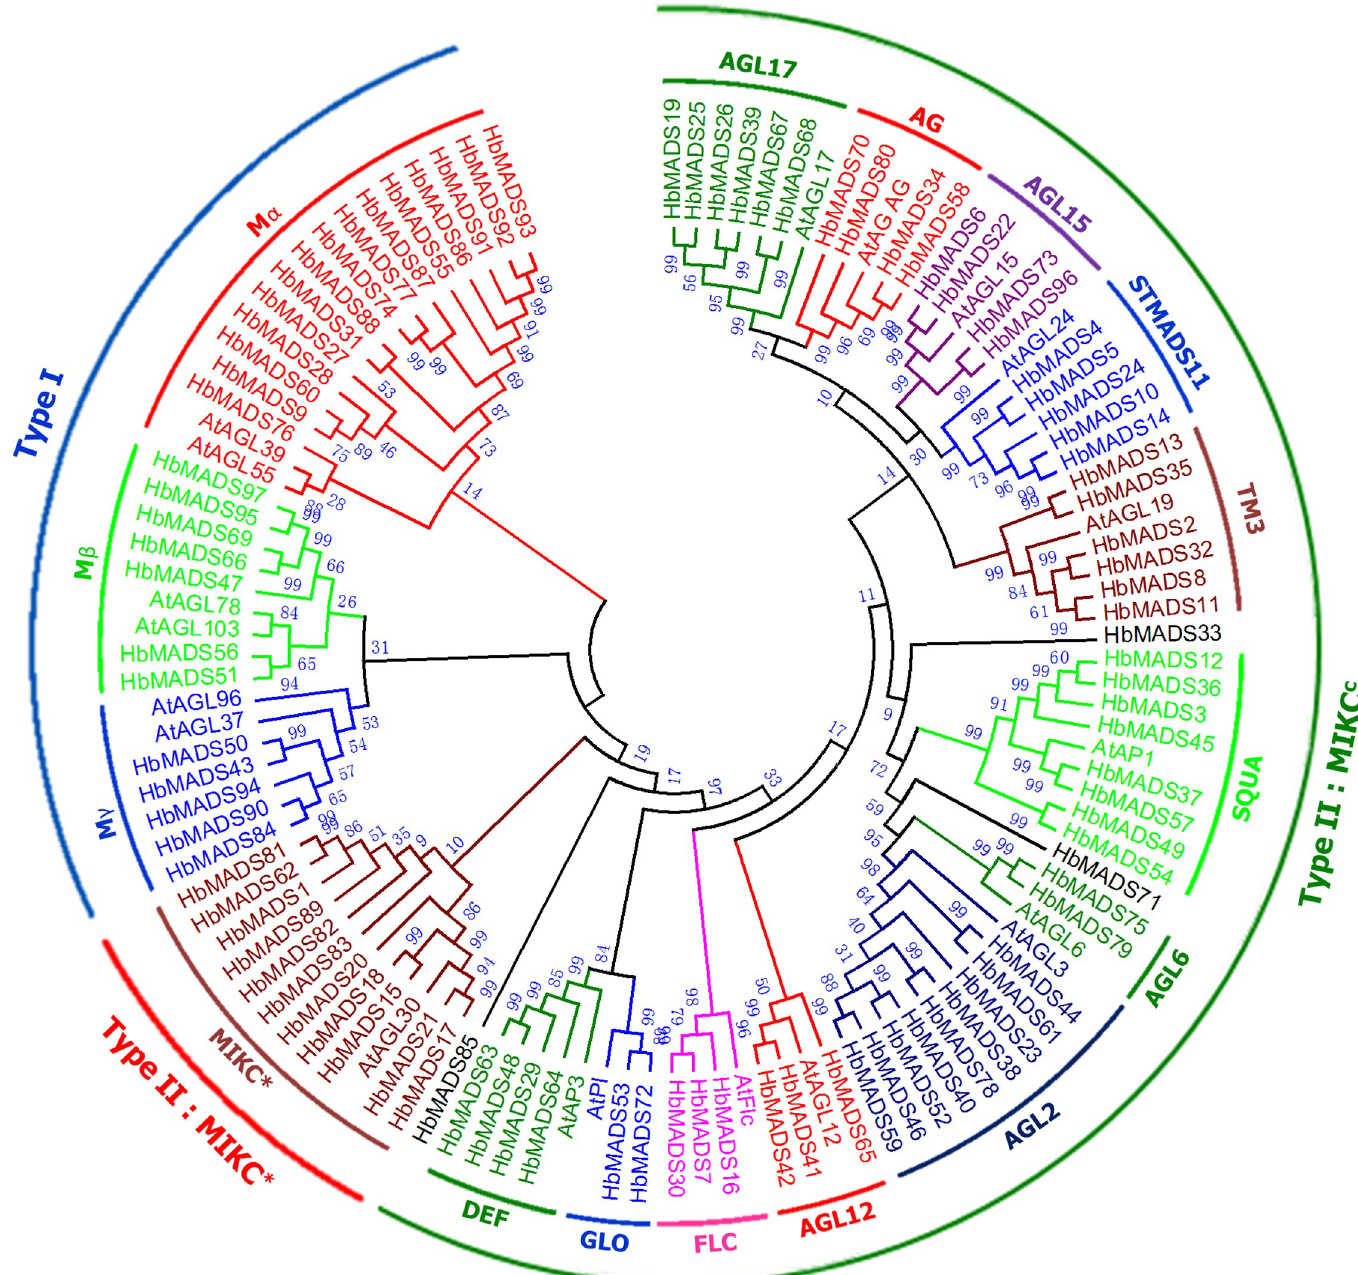
Fig 1. Maximum likelihood tree of MADS-box factors in the rubber tree. A total of 134 MADS-box proteins including 97 from the rubber tree (prefixed with ‘Hb’) and 19 representative sequences of well known clades in Arabidopsis (prefixed with ‘At’) were aligned using ClustalX2.0 [35]. The evolutionary distances were computed using the number of differences method [40]. All positions with less than 80% site coverage were eliminated, and a total of 256 positions in the final dataset were used to create the tree. The evolutionary analyses were conducted in MEGA7 [36]. The accession numbers of the Arabidopsis MADS-box proteins are provided in S4 Table. https://doi.org/10.1371/journal.pone.0214335.g001 the shortest peptide (152 aa) in HbMADS family of the rubber tree. Further phylogenetic anal- ysis using all MADS-box proteins from Arabidopsis and rice clustered HbMADS85 into MIKC � clade (S1 Fig). Therefore, the final MIKC � -type gene number in the rubber tree is 12.